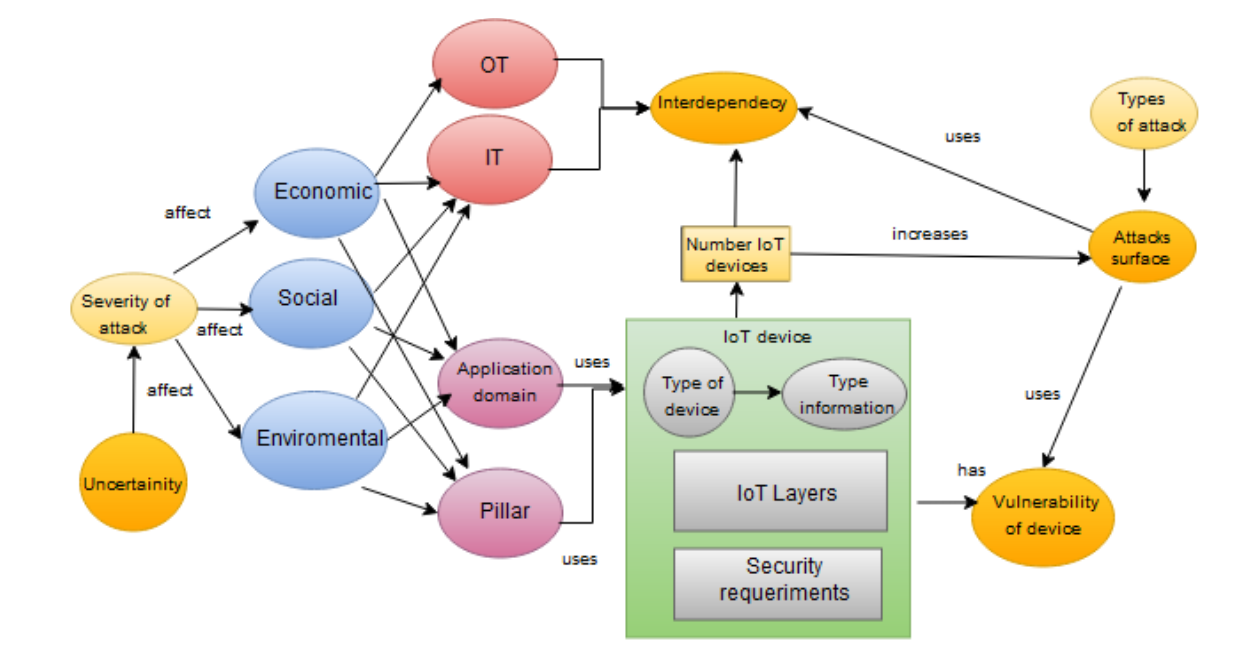
Figure 15. Second reference model for risk analysis in IoT systems based on IoT device factors.